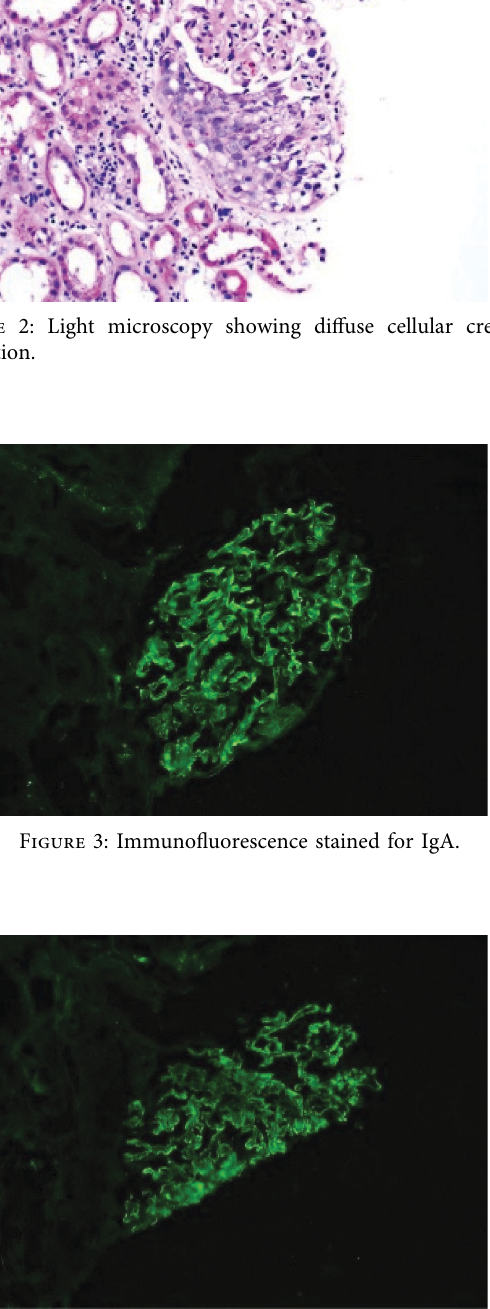
Figure 4: Immunofluorescence stained for